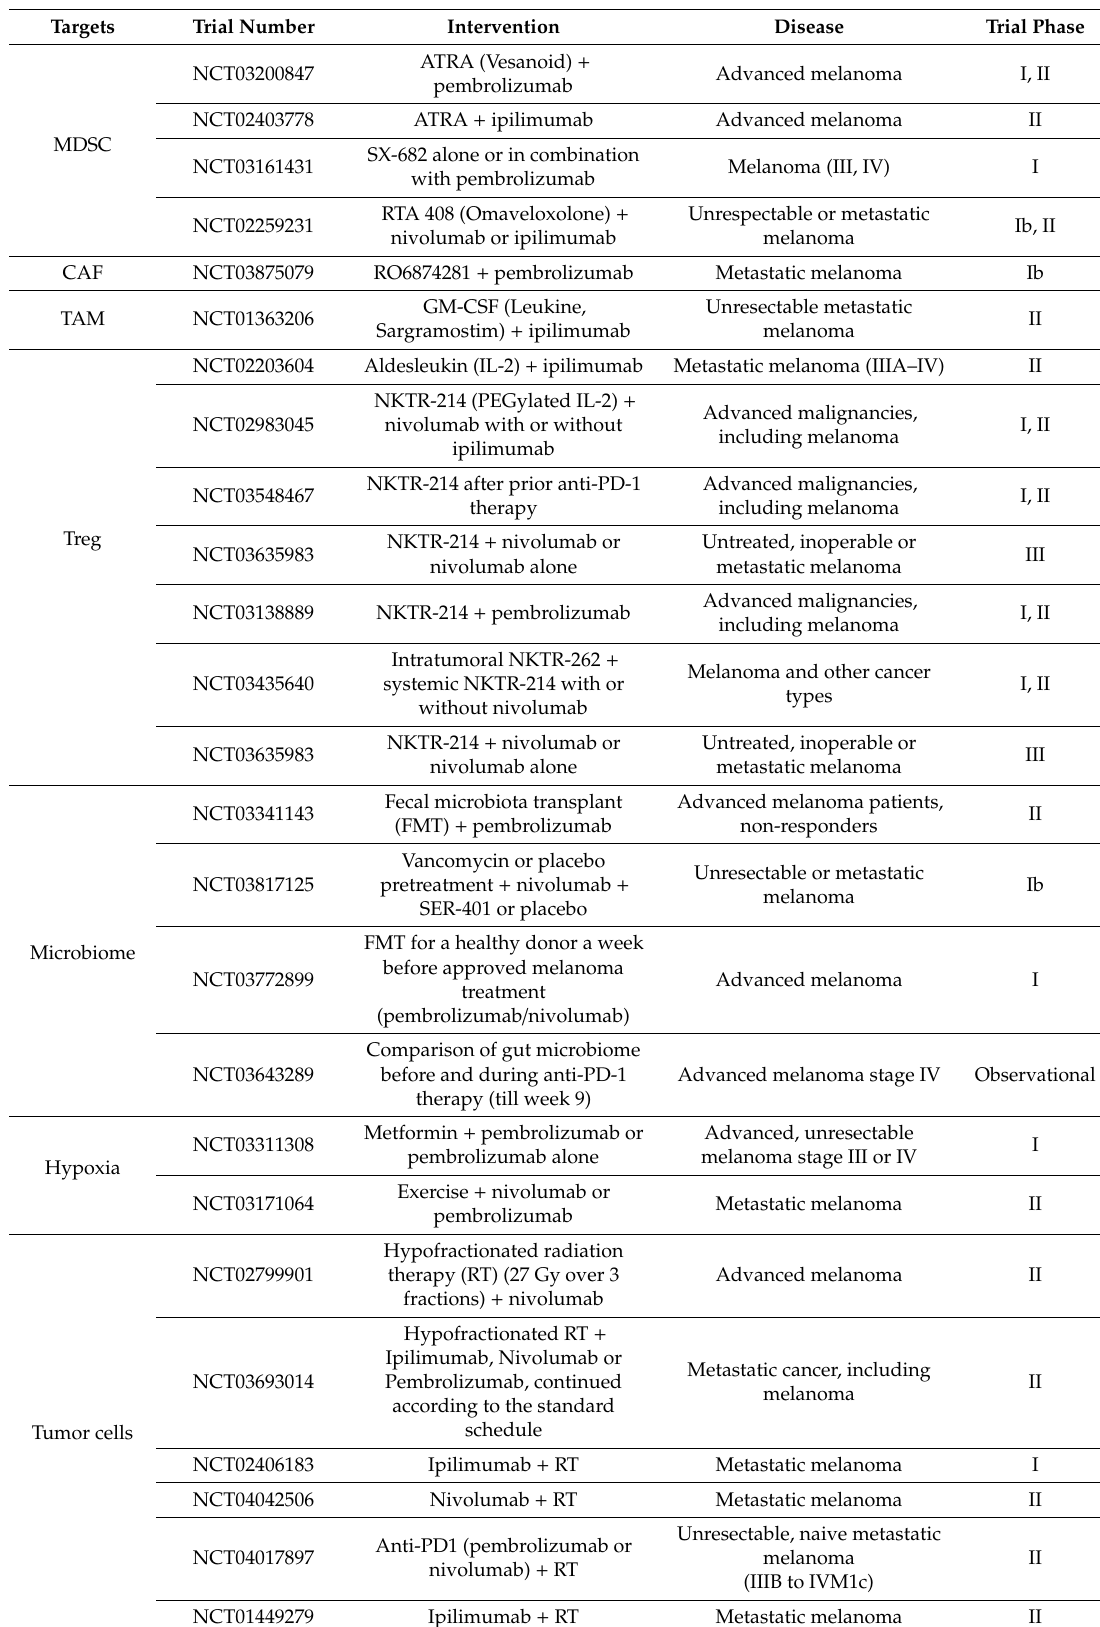
Table 1. Ongoing combinatorial clinical